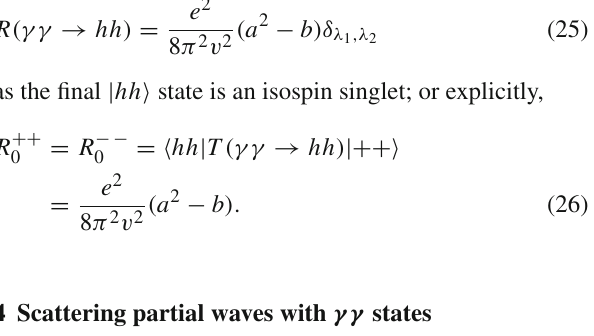
μ μ · ε ν · ε ν T ( 1 ) μν and ε T ( 2 ) μν (Eqs. (18) and (19)). All are invariant under θ → π − θ , that is, t – u exchange, a consequence 1 1 2 2